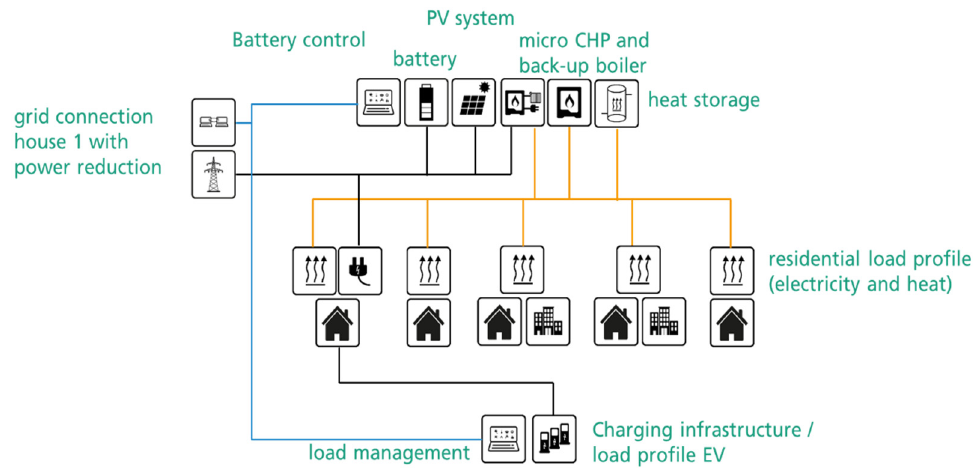
Figure 2. Simulated building block with five multi-family houses, including two with commercial areas, 20 kW p PV and 67 kWh battery system, CHP (73 kW th , 33 kW el ), 5000 l hot water tank, charging infrastructure with 30 × 11 kW-charging points, and connection to the public low voltage grid [53].